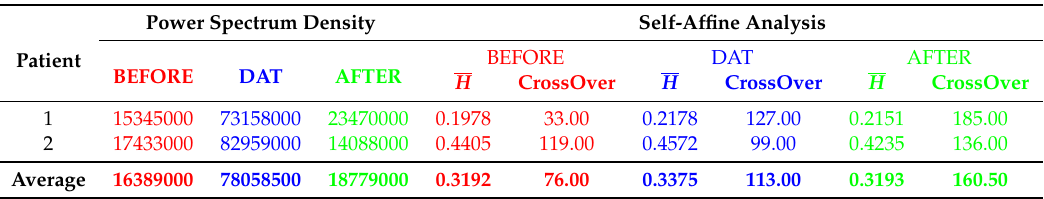
Table 6. Summary of the experimental results of Experiment